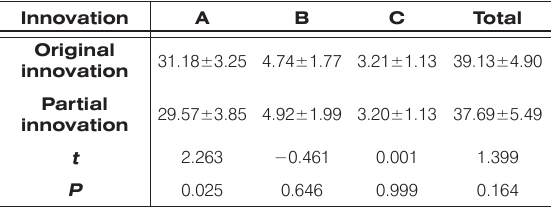
Table 4. Comparison of the evaluation scores of the clinical nursing studies with different innovation statuses Note: A: Level of the study; B: Value of the result; C: Effectiveness of the result.